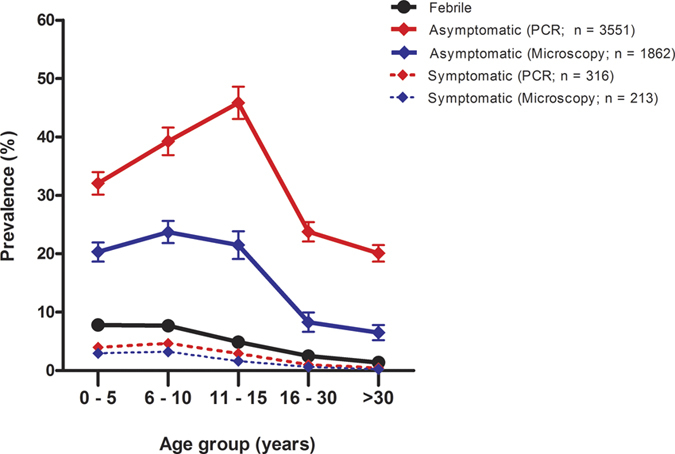
Age trends of febrile illness, asymptomatic and symptomatic malaria infection by microscopy and PCR in Lake Victoria.Error bars represent 95% confidence intervals.